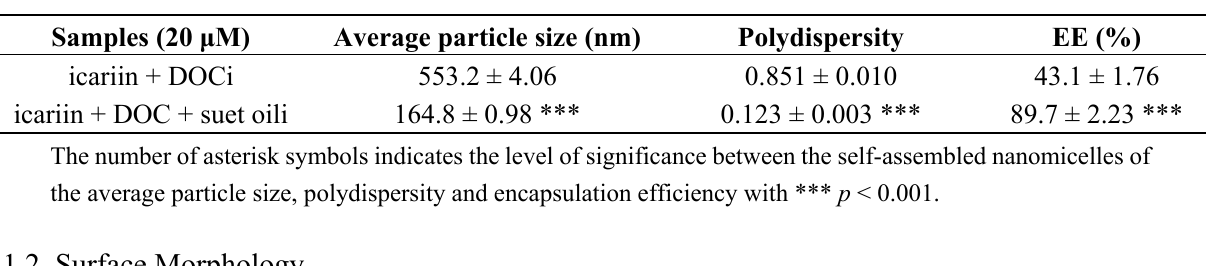
Table 1. Particle size, size distribution and encapsulation efficiency ( x ± S.D., n =